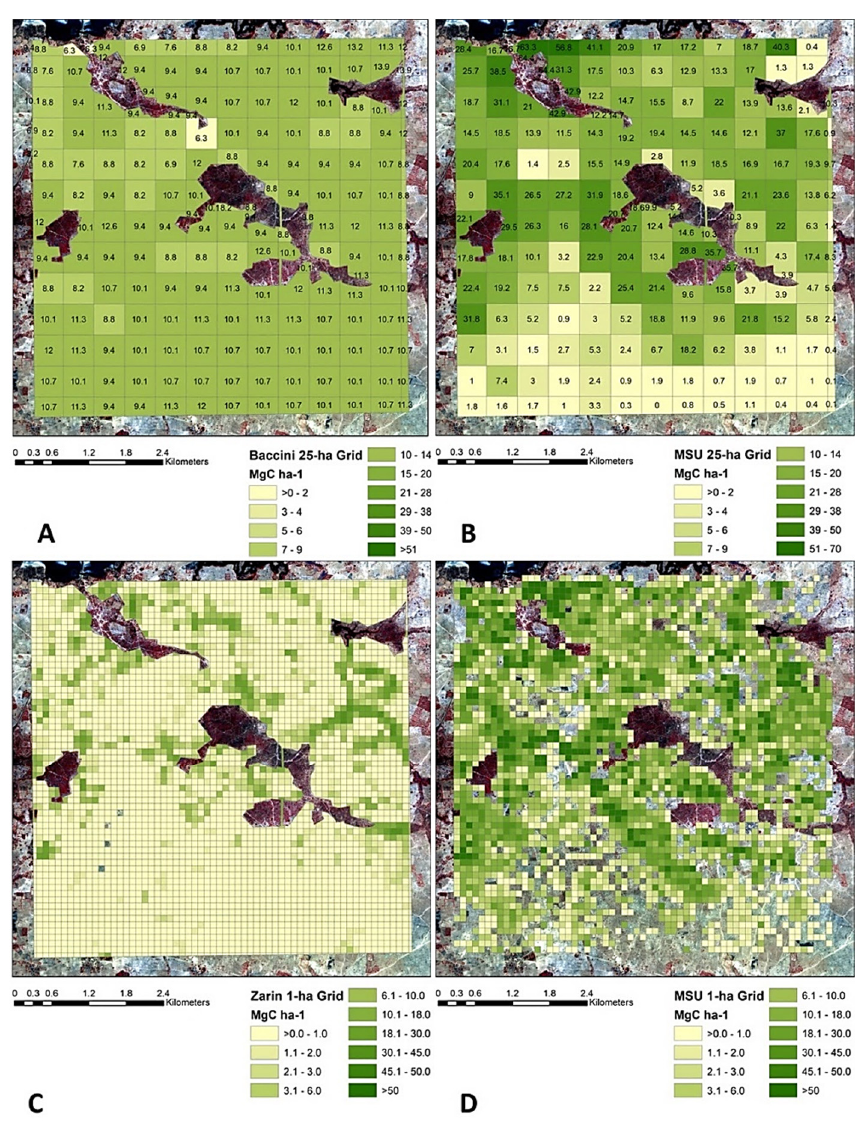
Figure 11. Comparison between landscape carbon estimates from this study and notable coarse resolution data. ( A ) Carbon from Baccini et al. using MODIS, 500 m data 25 ha grid. ( B ) This study when aggregated to 25 ha. ( C ) Carbon from Zarin et al. [53] using Landsat 30 m data, aggregated to 1 ha. ( D ) This study when individual tree measurements were aggregated at 1